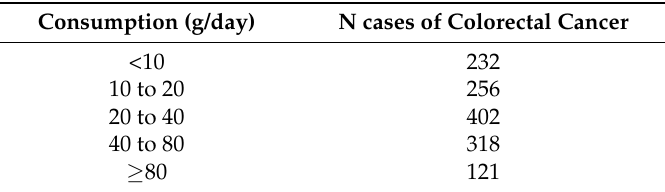
Table 2. European Prospective Investigation into Cancer and Nutrition (EPIC) study data of colorectal cancer and associated processed meat consumption (Norat et al., 2005